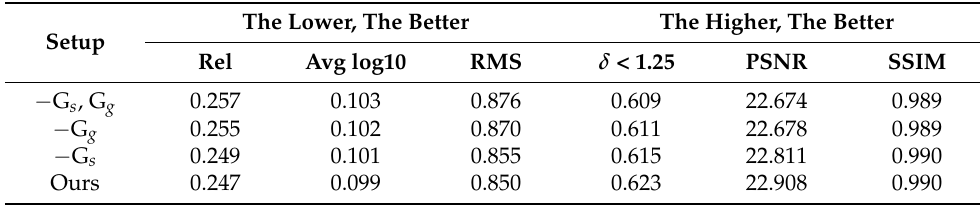
Table 3. Comparison of the different auxiliary tasks.